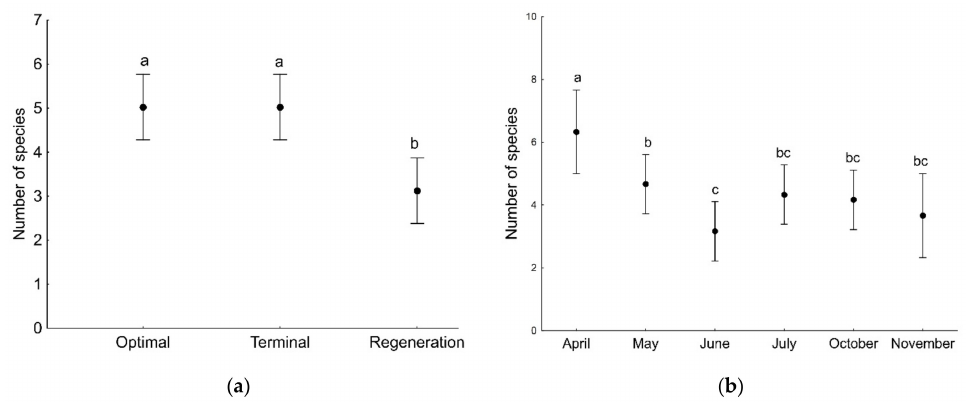
Figure 4. The number of spider species (mean with 95% confidence limits) recorded on tree branches in a single sample in three developmental phases of primeval oak–lime–hornbeam forest ( a ) and in particular sampling months ( b ). Different letters indicate significant differences between particular developmental phases ( a ) and particular sampling months ( b